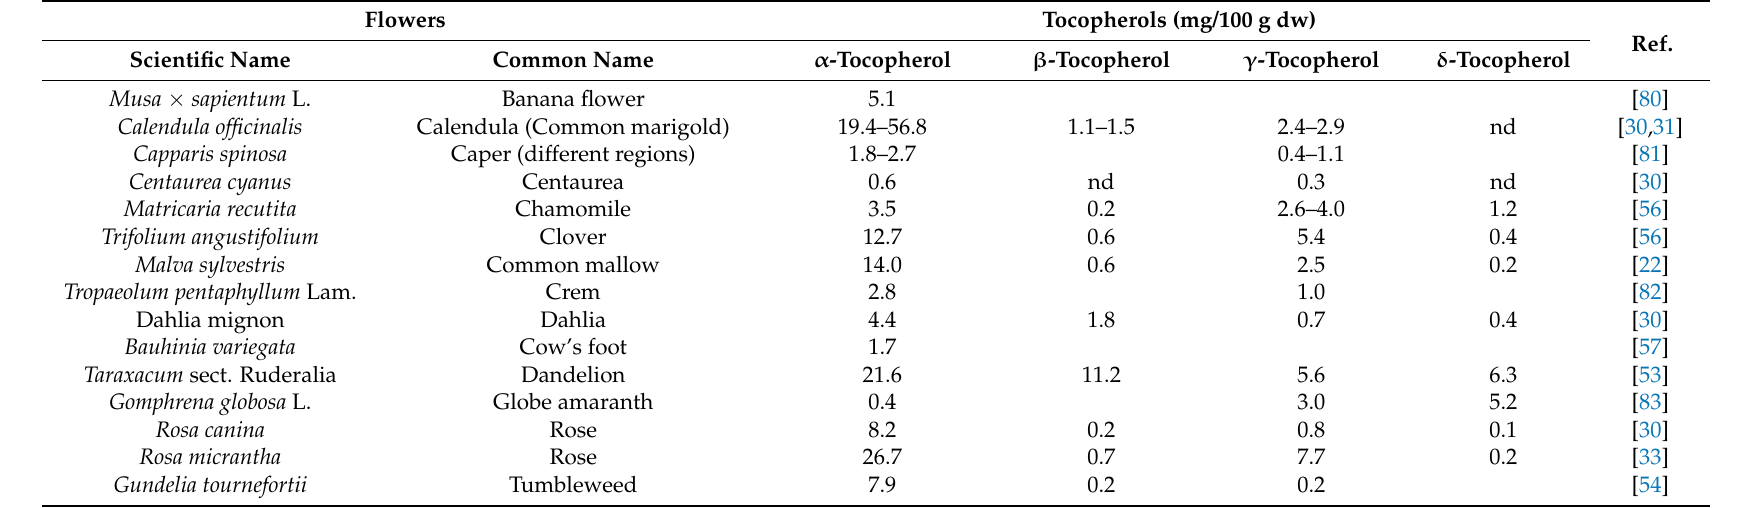
Table 4. Tocopherols determined in edible flowers mentioned in the